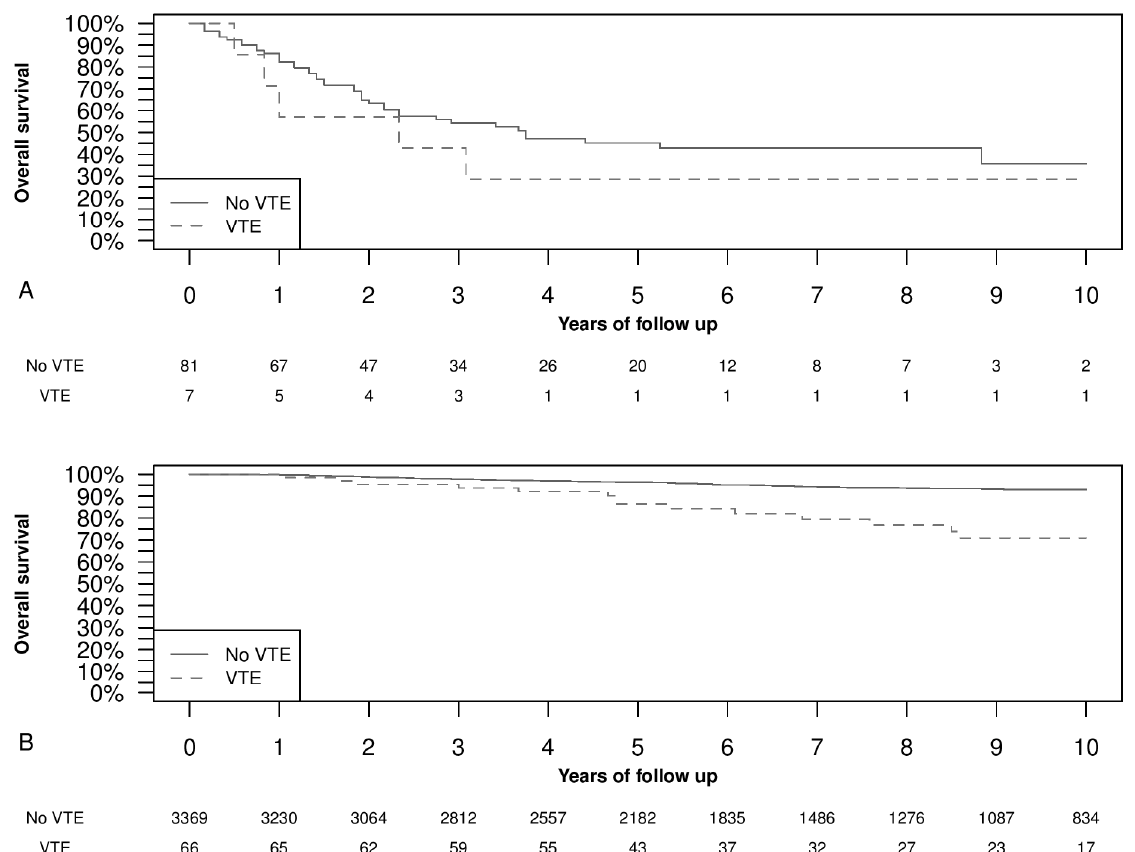
Figure 2. Kaplan–Meier curves of overall survival time divided into presence or absence of venous thromboembolism (VTE) events. Panel ( A ) TNM stage IV ( p = 0.332). Panel ( B ) TNM stages I, II, and III ( p < 0.05). The p -values refer to log-rank test.